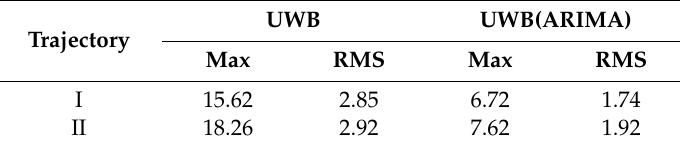
Table 2. Statistics of Euclidean Distance Errors in two trajectories